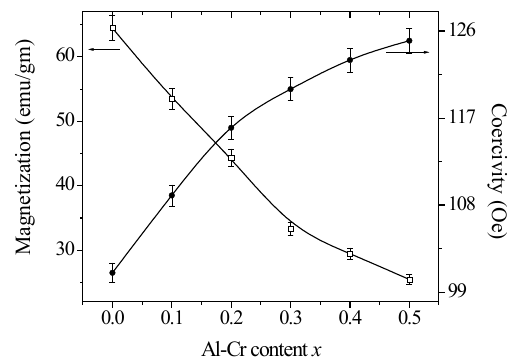
Figure 5. Variation of magnetization with applied field. Figure 6. Variation of saturation magnetisation and coercivity with